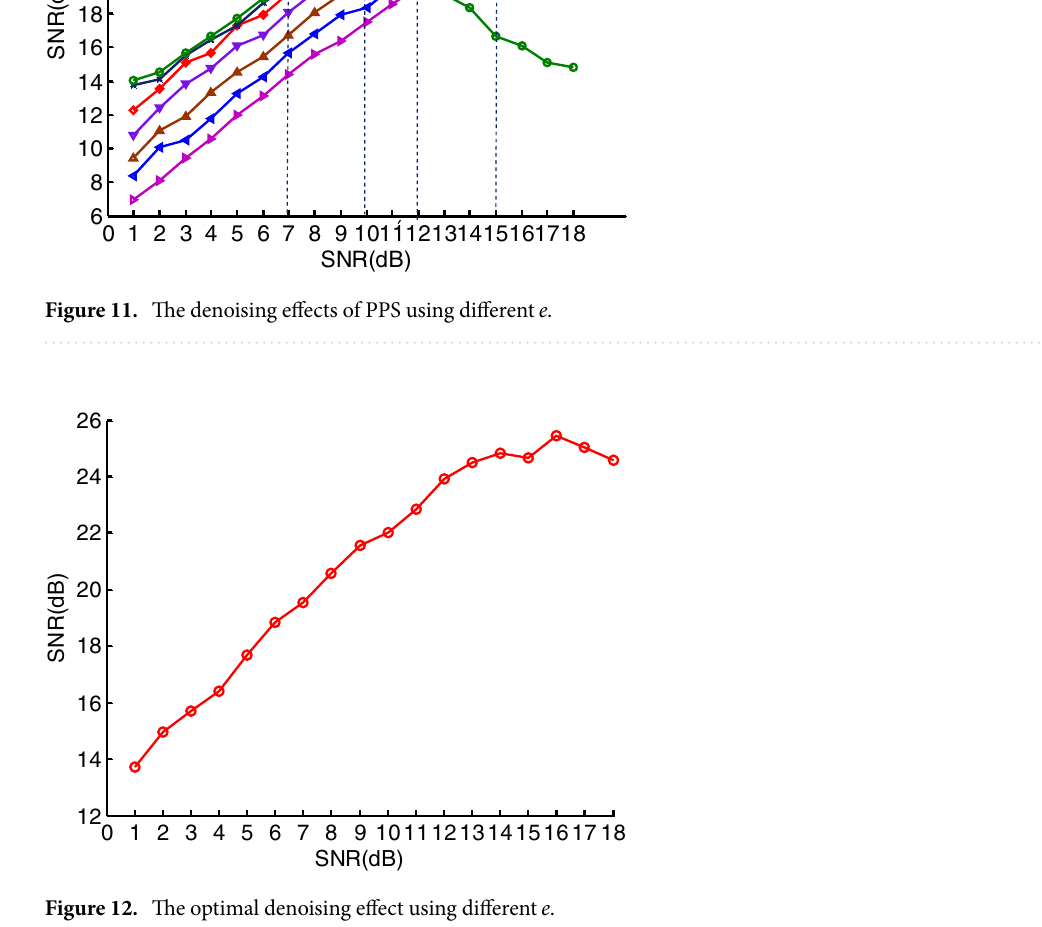
Figure 12. The optimal denoising effect using different e .